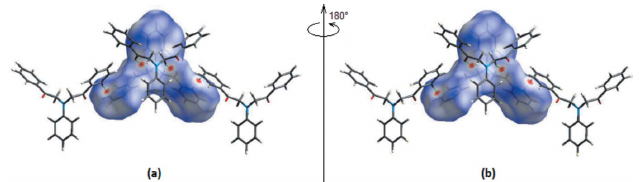
Figure 4 ( a ) Front and ( b ) back sides of the three-dimensional Hirshfeld surface of